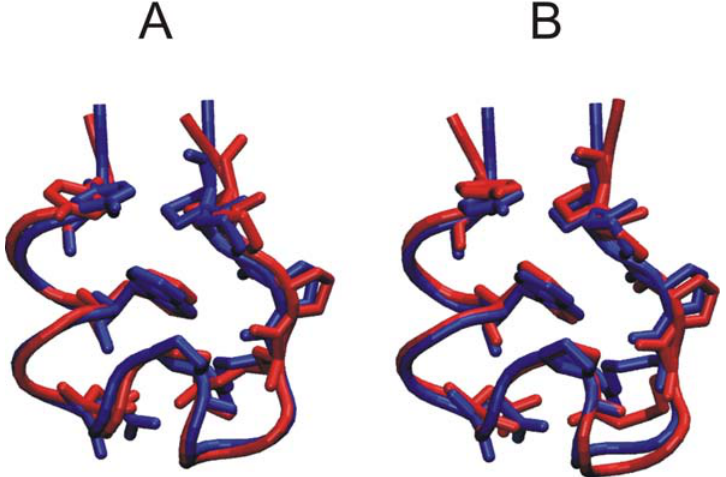
Figure 2. Superposition of the cluster centroids (structure closest to the average structure of the cluster) from the most populated cluster during the final part (last 10 ns) of the BP- RexMD (A) and T-Rex MD (B) simulations (red structures) on the native Trp-cage structure (first entry of pdb1L2Y; in blue). The protein backbone is in tube representation , Trp , Asp , Pro , Arg , Pro , Pro and Pro are shown as stick and residues Tyr 3 6 9 12 16 17 18 19